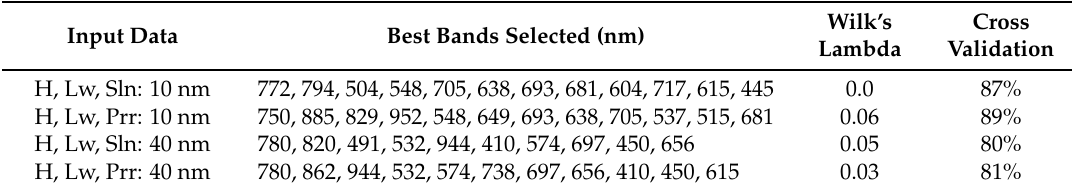
Table 6. Classification reflectance result using STEPDISC for H, Lw, salinity, and Prr in early and late stage